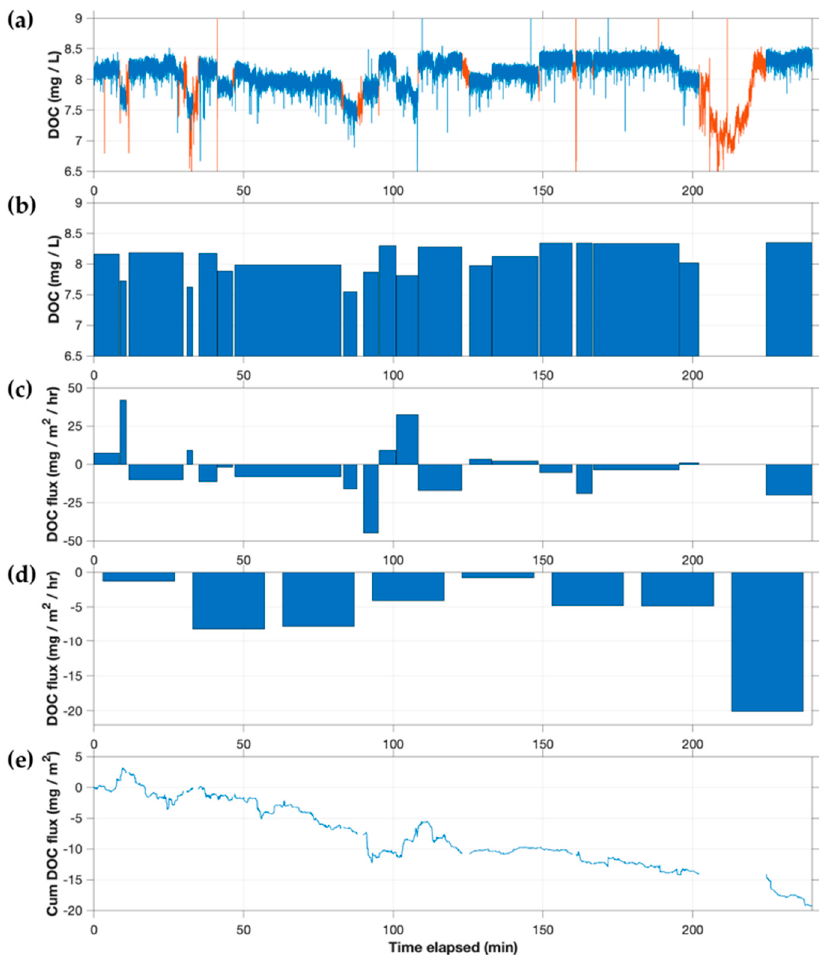
Figure 9. DOC and DOC flux at the Concord River site (CNR). ( a ) DOC time series showing omitted sections in red. ( b ) Manually identified ‘plateaus’ of DOC concentration in time series, shown as average DOC value for each plateau. ( c ) DOC flux calculated individually for each plateau. ( d ) DOC flux calculated in 30 min flux windows by averaging all available w ′ c ′ values in each window. ( e ) Cumulative DOC flux.